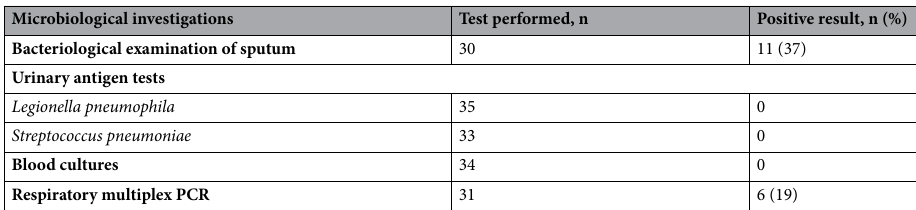
Table 2. Microbiological diagnostic work-up. The mPCR was not performed in 5 (14%) patients for logistical reasons. Sputum was not obtained in 6 (17%) patients, due to inability to obtain sampling of adequate cytological